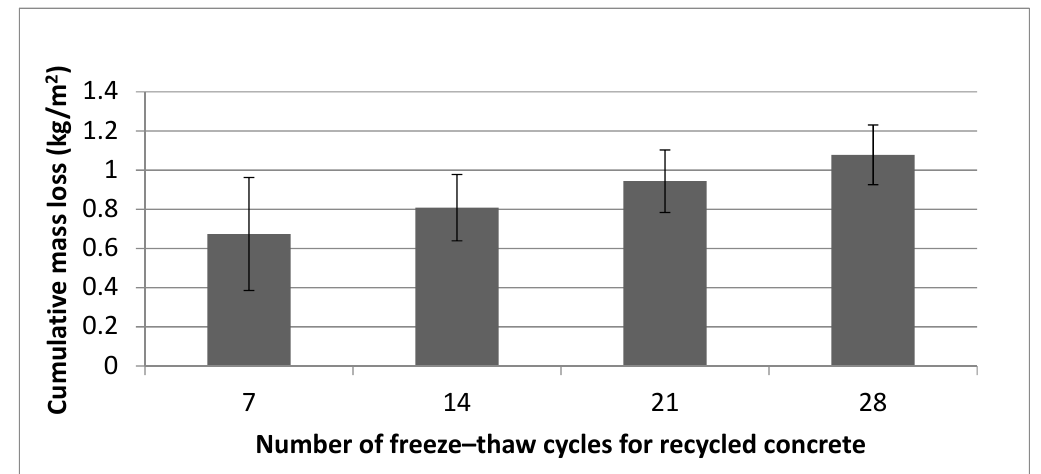
Figure 11. Cumulative mass loss of recycled aggregate concrete samples versus freeze–thaw cycles.